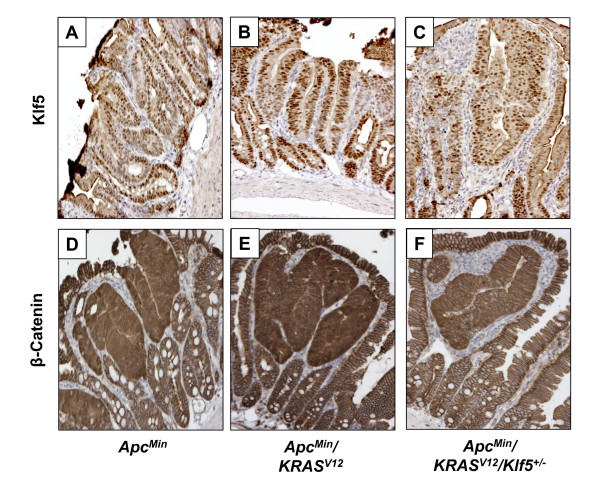
Immunostaining of Klf5 and β-catenin in intestinal adenomas derived from mutant mice. Adenomatous tissues from ApcMin, ApcMin/KRASV12 and ApcMin/KRASV12/Klf5+/- mice were formalin-fixed, paraffin-embedded and cut into 5 μm sections. Slides were then stained with Klf5 and β-catenin antibodies after deparaffinization and antigen-retrieval. Protein expression was determined upon secondary antibody treatment and color development using DAB chromogen (brown stain). Nuclei were then counterstained blue using hematoxylin. Panels A & D represent Klf5 and β-catenin staining in ApcMin tumor tissues. Panels B & E represent comparative staining in ApcMin/KRASV12 tumor tissues, while panels C & F represent staining in ApcMin/KRASV12/Klf5+/- tumor tissues.